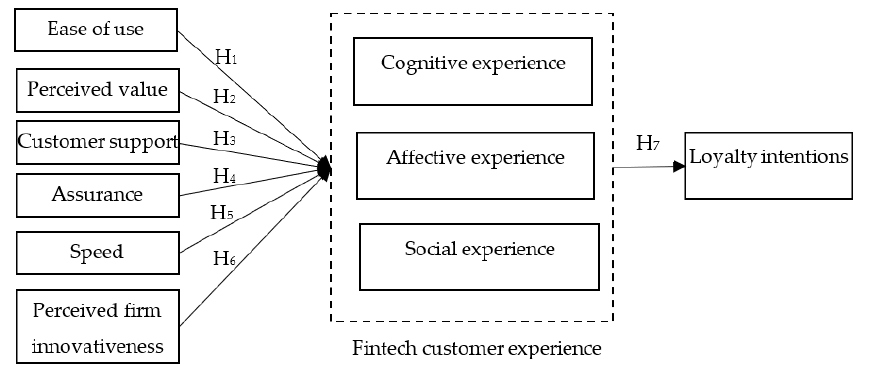
Figure 2. The research model .